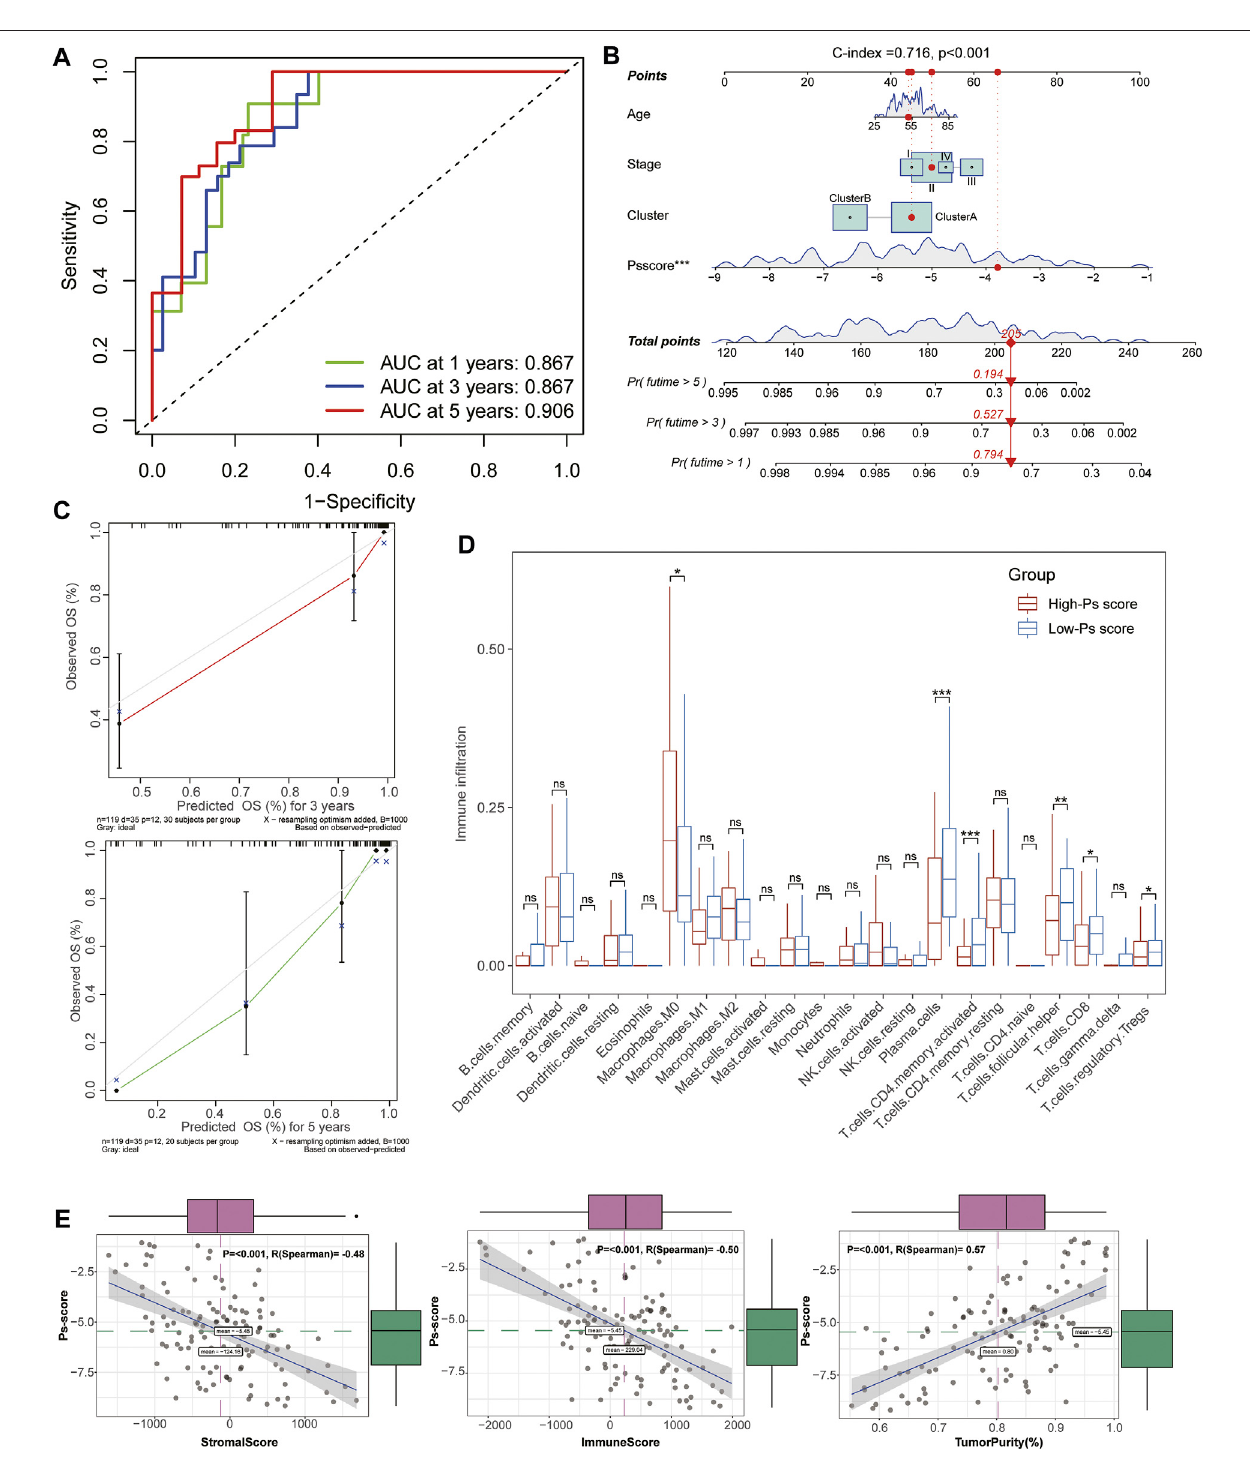
FIGURE 5 | EstablishmentandevaluationofthePs-score-relatedprognosticmodelforpatientswithTNBC. (A) Time-dependentreceiveroperatingcurvesof1-,3-,and5- year survivalfor patients with TNBCusing Ps-scores. (B) Combined nomogram for predicting the probability of 1-, 3-, and 5-year survival for patients with TNBC. (C) Calibration curveoftheestablishednomogramwith3-and5-yearsurvival,respectively. (D) Immunein fi ltrationanalysisrevealedthatsubstantialimmunecellsweresigni fi cantlyinhibitedinhigh Ps-score groups. (E) Correlation analysis shows the Ps-scores signi fi cantly positively associated with the levels of tumor purity ( R = 0.57) and negatively associated with stromal and immune scores ( R = – 0.48 and R = – 0.50, respectively).